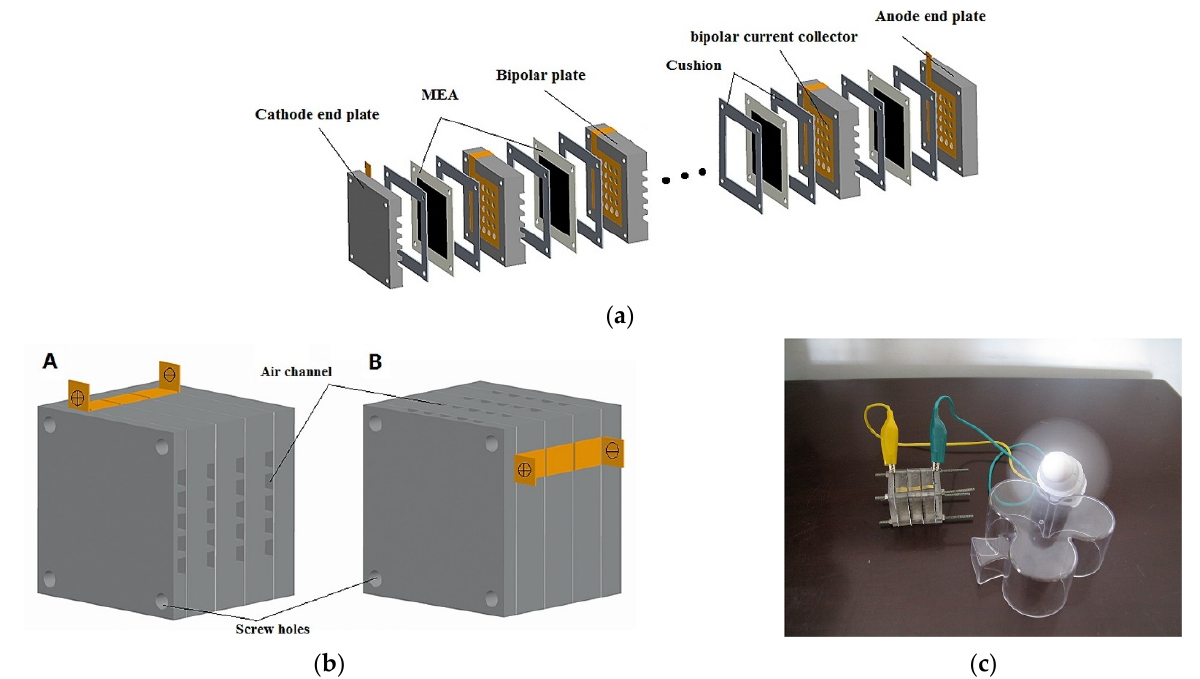
Figure 14. ( a ) Schematic of the proposed bipolar PS-DMFC stack structure; ( b ) the tested orientations of bipolar plates (BPs); ( c ) picture of bipolar PS-DMFC stack applied to power a small operating fan. Reproduced from [147] with permission from Elsevier 2017.